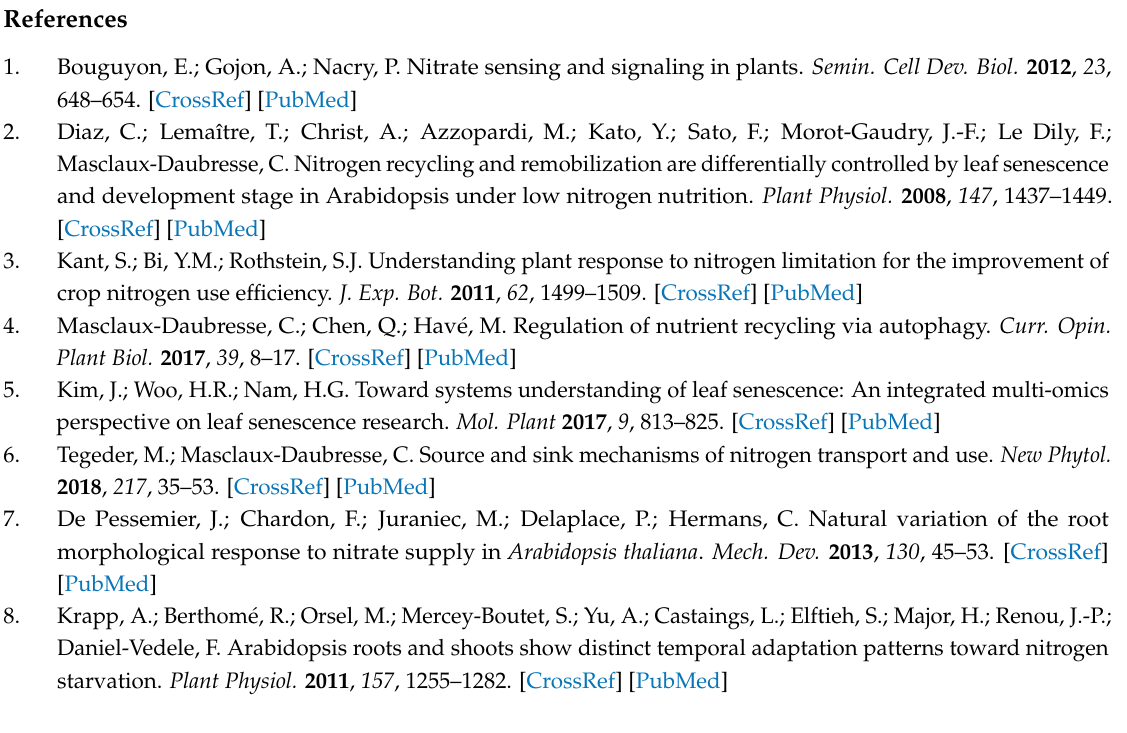
Table S1: Raw dataset corresponding to all measurements made on four Arabidopsis accessions in six N supplies for three independent experiments, Table S2: Percentage of explained variance of investigated traits, Table S3: Nutrition indexes of different N pools in the four Arabidopsis accessions, Table S4: ANOVA of the five nutrition indexes in four Arabidopsis accessions growing in six different N supplies in three independent experiments., Table S5: Pearson’s correlation matrix of investigated traits, Table S6: Parameters of the descriptive model for the estimation of morphological traits according to N nutrition, Figure S1: Slope (A) and intercept (B) of linear regression of SFM against NNI for the 4 Arabidopsis accessions, Figure S2: Nutrition Use Efficiency in four Arabidopsis